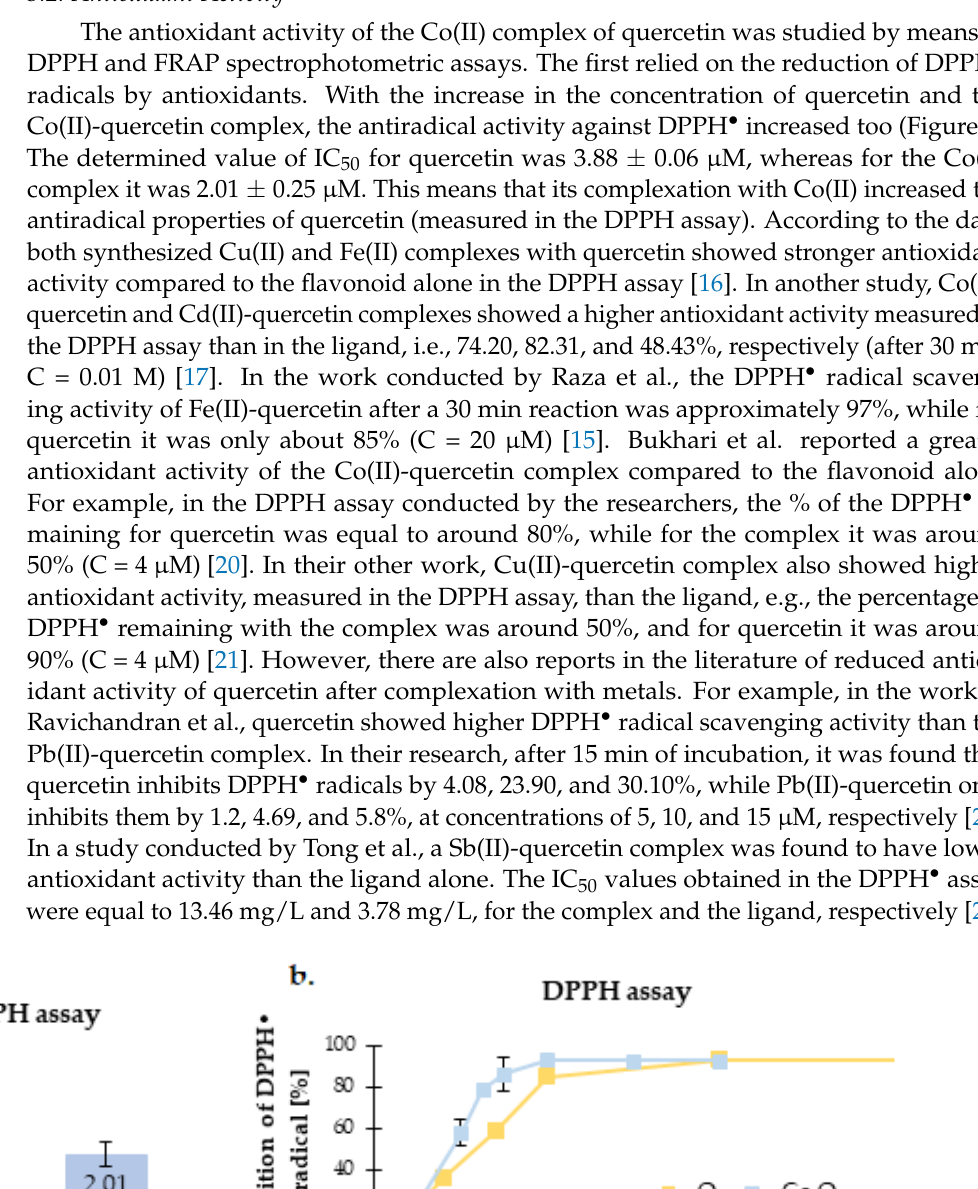
Figure 7 . The FRAP values obtained for quercetin (Q) and Co(II) complex of quercetin (Co-Q). Mean values from three independent experiments ± SD are shown. The quercetin and the Co(II) complex of quercetin revealed pro-oxidant activity in the Trolox oxidation assay. The reaction between tested phenolic compounds and H 2 O 2 catalyzed by horseradish peroxide provide the phenoxyl radicals. The obtained phenoxyl radicals undergo a reaction with Trolox, the Trolox is oxidized to create Trolox radicals, and then transformed into Trolox quinones (with maximum absorption at 272 nm), and the phenoxyl radicals are transformed into phenolic compounds. The pro-oxidant activity